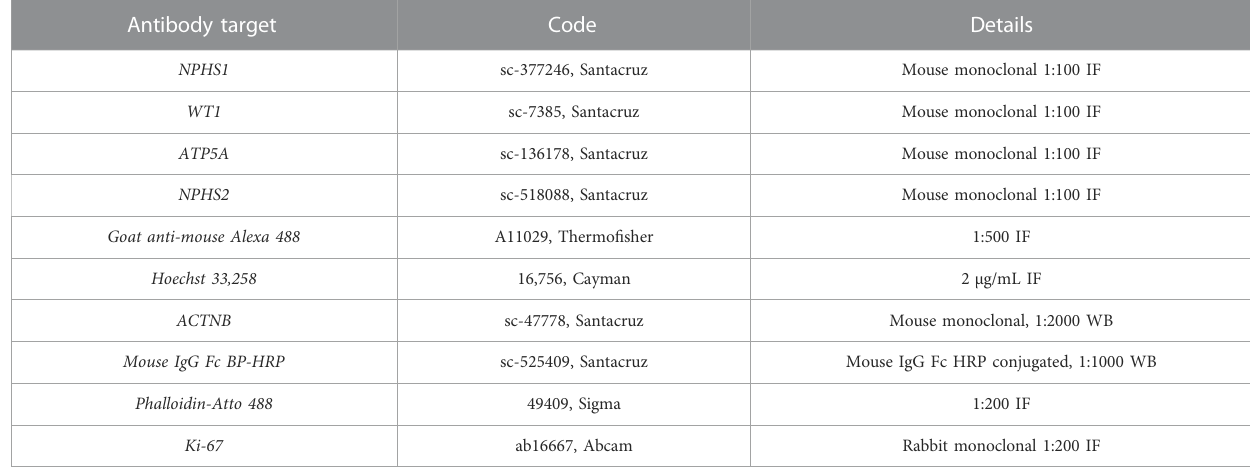
TABLE 1 Antibodies and reagents used in immuno fl uorescence (IF) and western blot (WB) analysis. Antibody